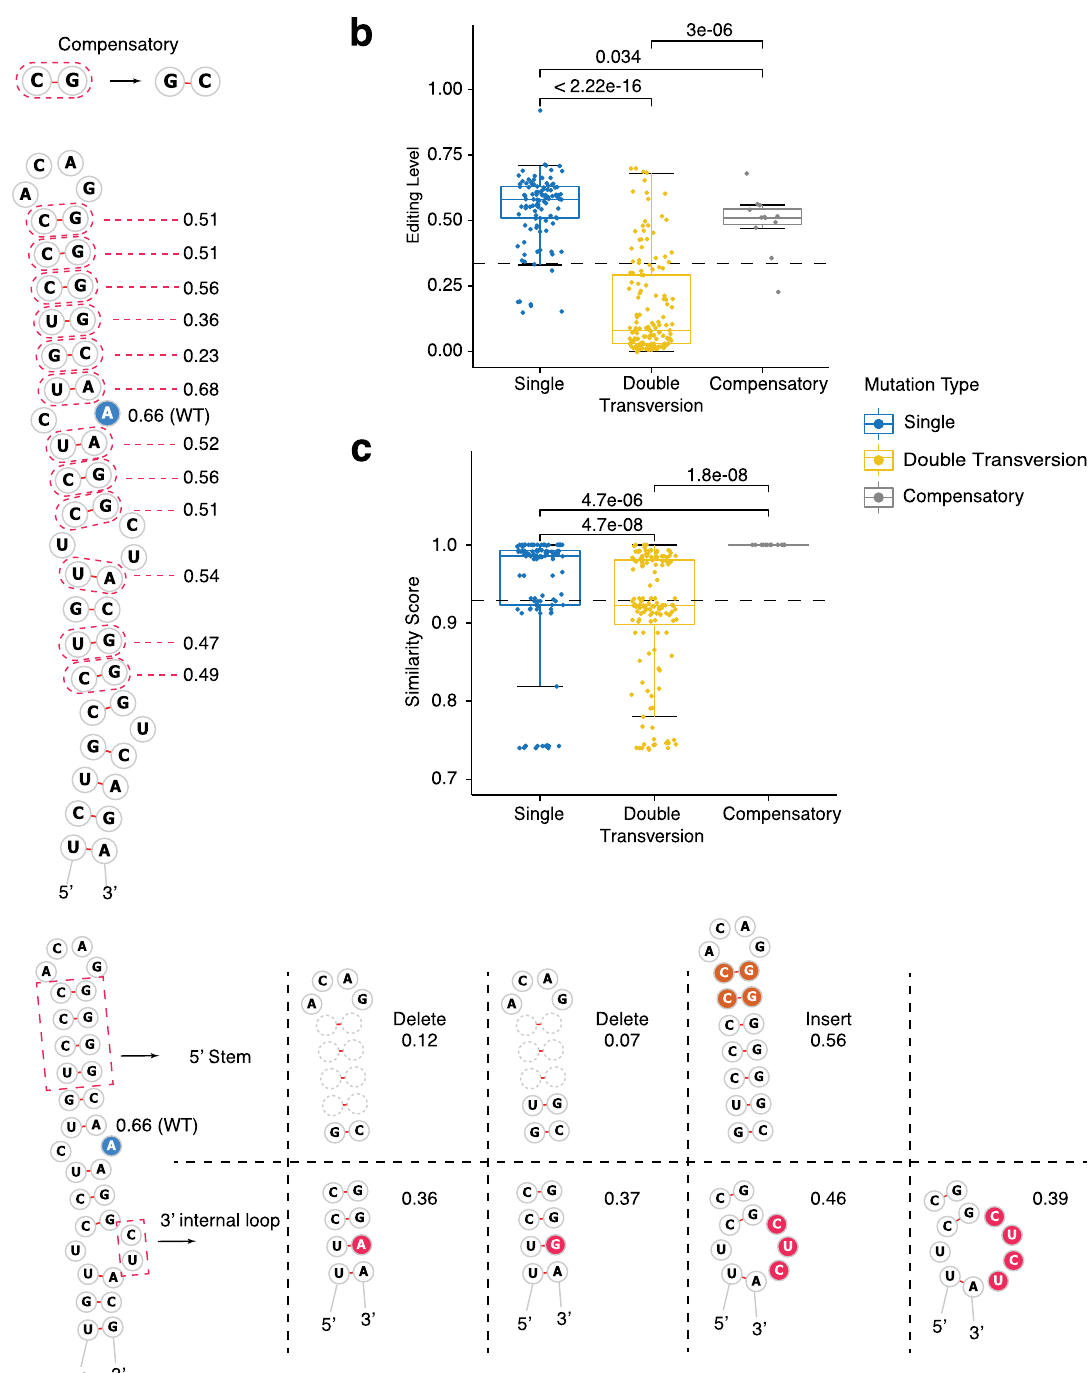
Fig. 4 Examples of RNA secondary structure changes of NEIL1 variants. a Compensatory mutation generally maintains a high editing level. Editing site is highlighted in blue. The dashed circle marks the location of compensatory double mutation. The b editing level and c similarity score (normalized score calculating the similarity of the MFE structure of each variant to the WT) vary by different mutation types. Single mutation (blue dot); double-transversion mutation (yellow dot); compensatory mutation (gray dot). The data points shown are the average editing level from six biological replicates. Boxplot: center line, median; box limits, upper and lower quantiles; whiskers, ±1.5× interquartile range (IQR). The P values from two-sided Wilcoxon rank-sum test are shown on each test set. d Alterations in the 5 ′ stem and 3 ′ non-stem structure elements affect editing level. Editing site is highlighted in blue and mutation region shown as dashed circle (deletion of stem from the 5 ′ stem), orange highlight (insertion of stem), or red highlight (mutation, deletion, or insertion of nucleotides of the 3 ′ internal